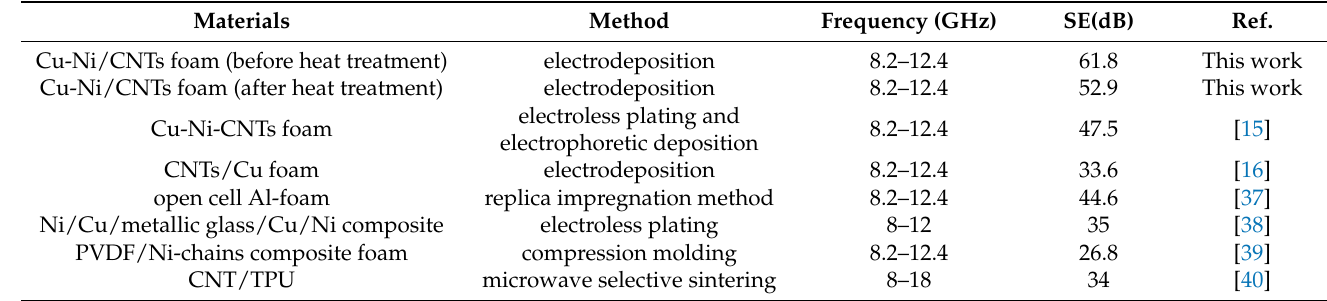
Table 2. The shielding performance comparison of different